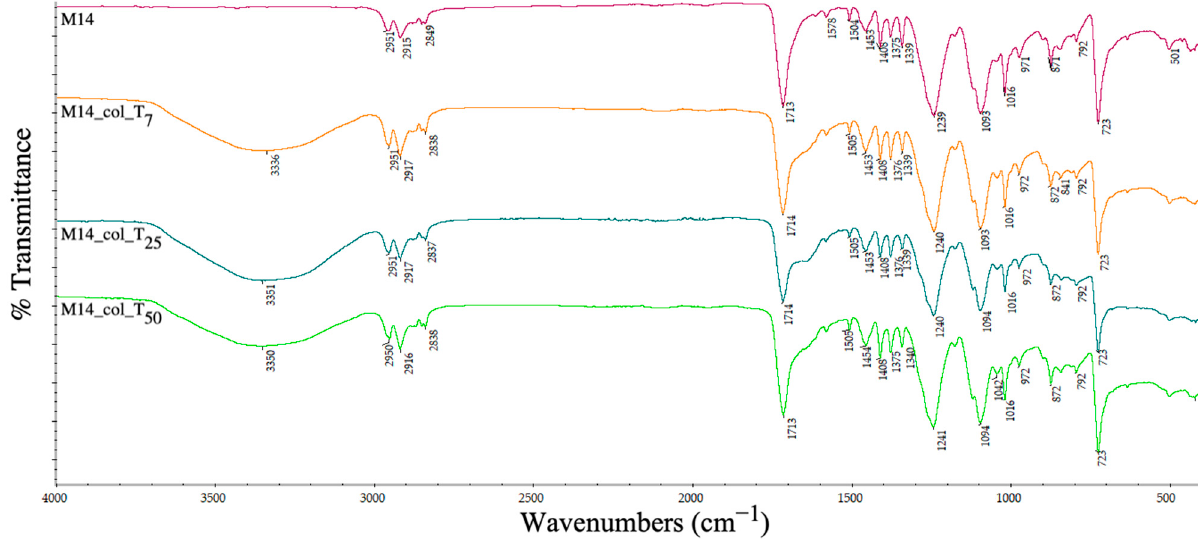
Figure 25. ATR spectra of PET–HDPE–Fe nano-powder composite pellets before and after collagen deposition at days 7 (T 7 ), 25 (T 25 ) and 50 (T 50 ).